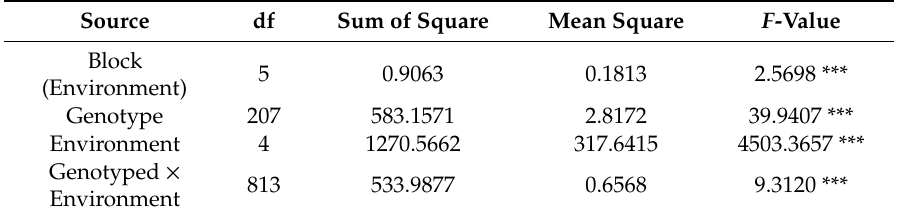
Figure 2. Phenotypic variations of mesocotyl elongation among three culture media. ( a ) Mesocotyl length of 208 rice accessions measured in soil culture with three sowing depths. ( b ) Mesocotyl length variation in sand, soil culture with 6 cm sowing depth and water. Table 1. ANOVA for mesocotyl length under di ff erent